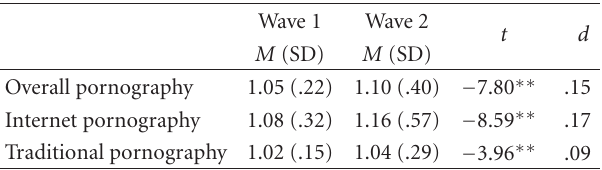
Table 6: Paired t -test results among di ff erent types of pornographic materials by